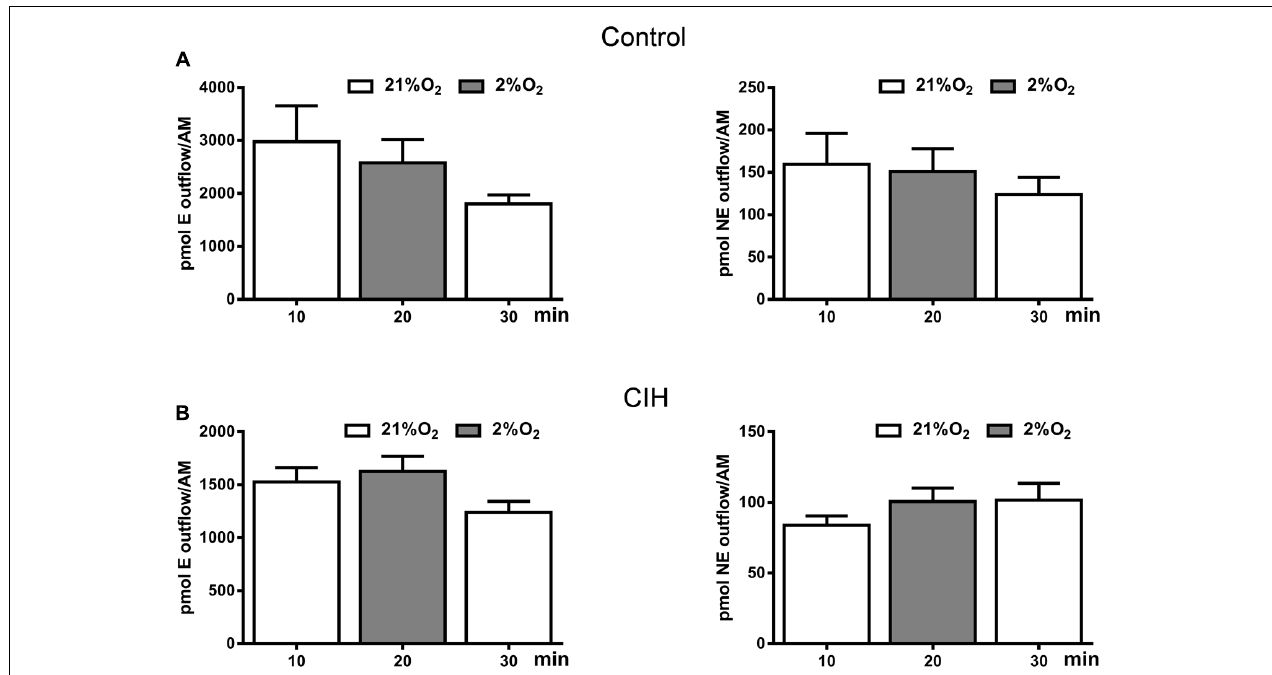
FIGURE 6 | Catecholamine outflow from control and CIH guinea pig adrenal medulla. Time course of endogenous epinephrine (E; left) and norepinephrine (NE; right) outflow from control (A) and CIH (B) guinea pig AM in response to basal (21% O 2 ) or hypoxia (2% O 2 ) conditions, expressed as pmol/AM. Data are mean ± SEM ( n = 4–6); One-way ANOVA with Tukey’s multiple comparison